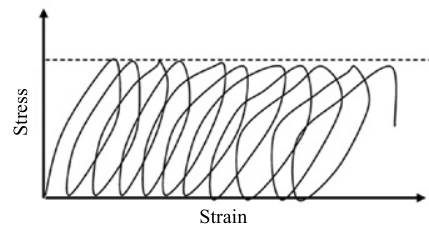
Figure 7. Strain–stress curve sketch